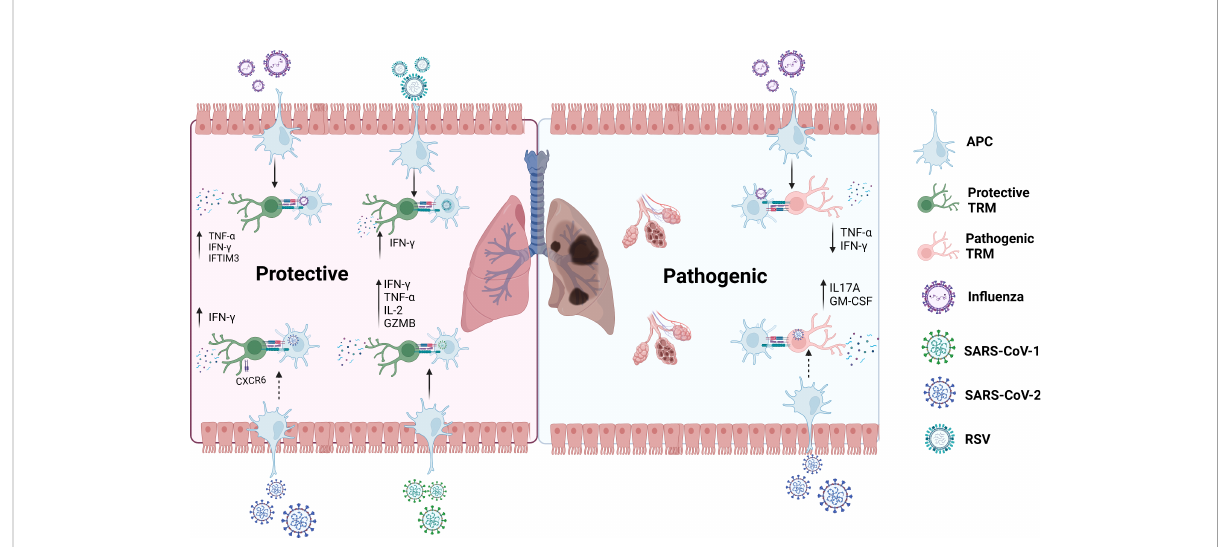
FIGURE 4 Roles of TRM cells in RSV, In fl uenza, SARS-CoV-1 and SARS-CoV-2.In the secondary infection, TRM cells rapidly react to protect the host from In fl uenza, RSV and SARS-CoV-1 through secreting important molecules such as IFN- g , TNF- a , and IL-2. It may also have the same effect in SARS-CoV-2. On the other side, TRM cells could also arouse pathogenic effects when the host is infected with In fl uenza, which might also happen in SARS-CoV-2 infection.GZMB: granzyme B. GM-CSF: granulocyte-macrophage colony-stimulating factor. dotted line: possible